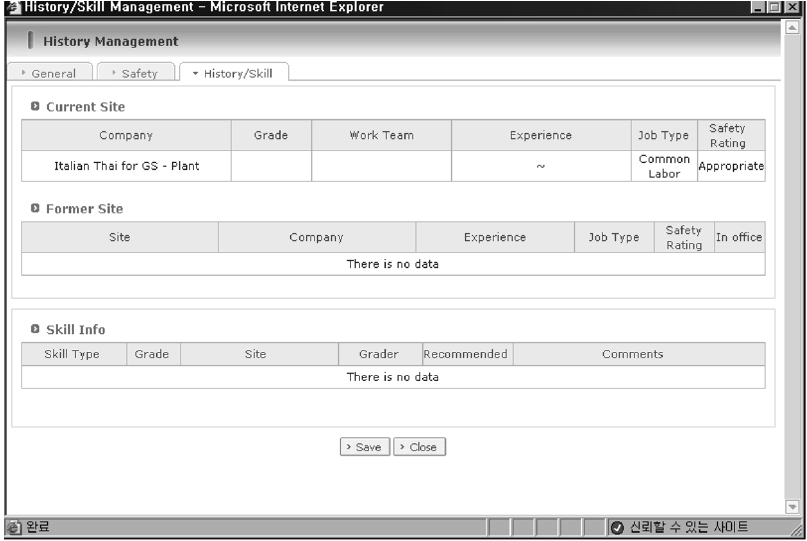
Fig. 7. History/Skill window